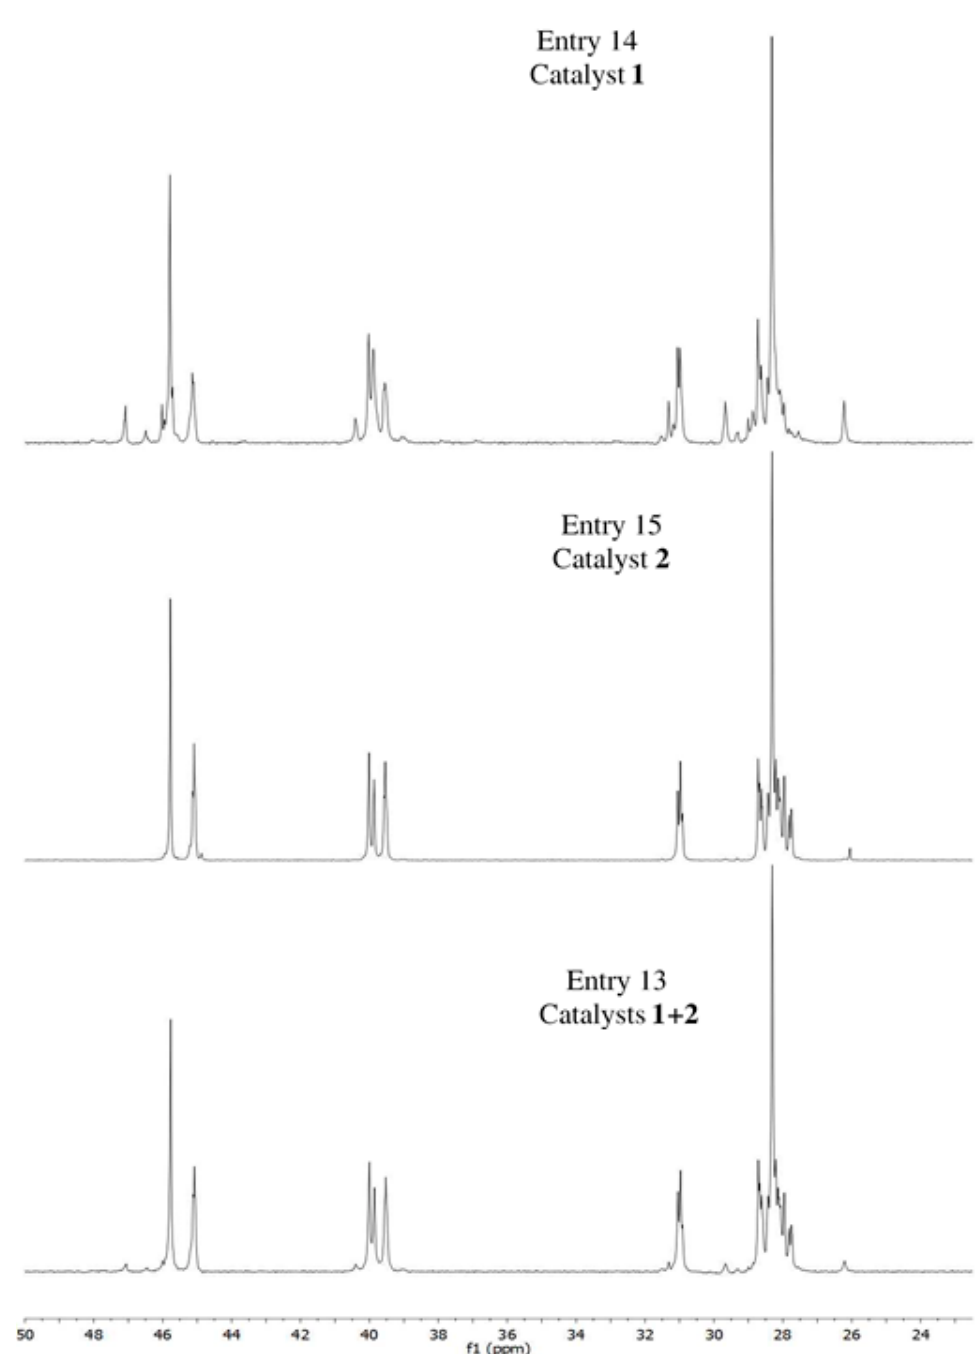
Figure 3. Comparison of 13 C-NMR spectra of poly(ethylene– co –norbornene) samples entry